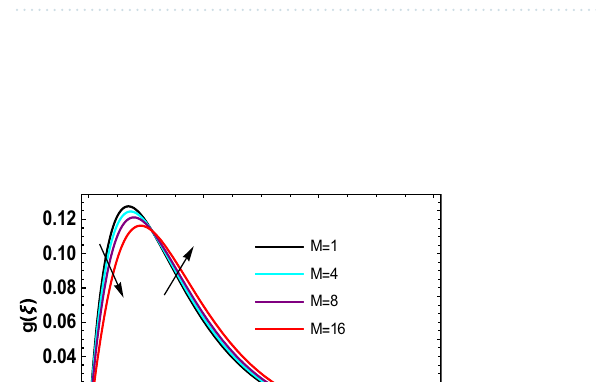
Figure 5. Impact of M upon f ′ (ξ) .